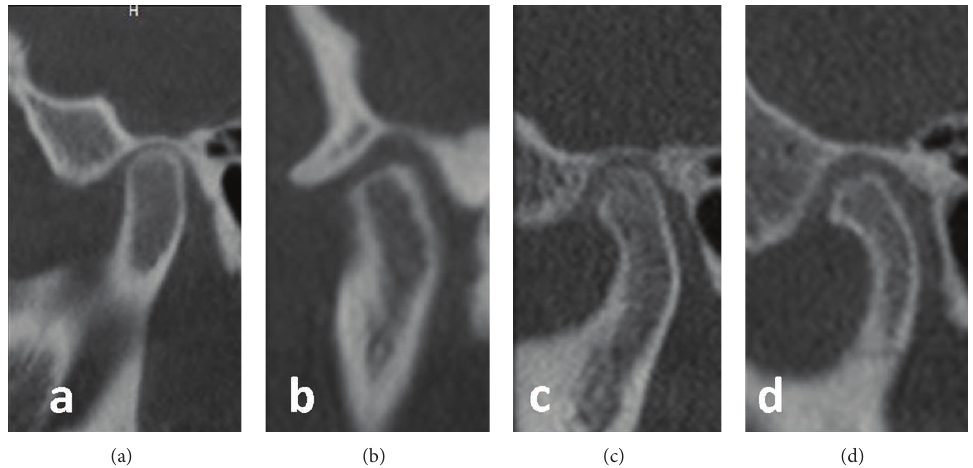
Figure 3: The sagittal condyle morphology: (a) without osteoarthritis (OA), (b) flattening, (c) erosion, and (d) osteophyte. Table 1: The articular eminence and RGF thickness measurements according to gender. Male Female 𝑃 Mean ± SD Mean ± SD 49.66 ± 6.88